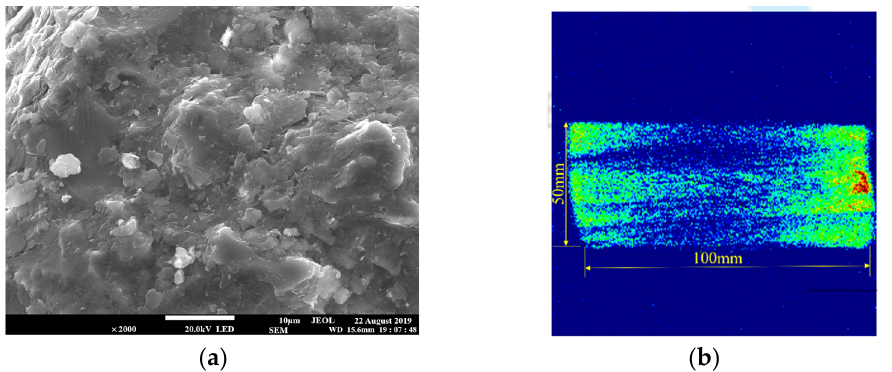
Figure 2. Detailed observation of the sample: ( a ) Scanning electron microscope (SEM) image; ( b ) magnetic resonance imaging (MRI) pseudo ‐ color image.